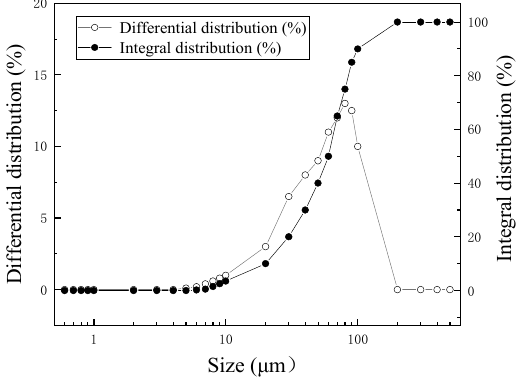
Figure 2. Grain size distribution curve of the whole tailing sand. Table 1. Basic physical parameters of tailings.